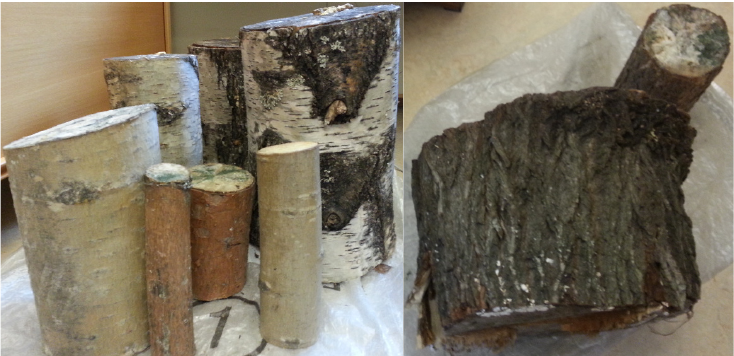
Figure 1. The nine tree trunk sections that were used in the